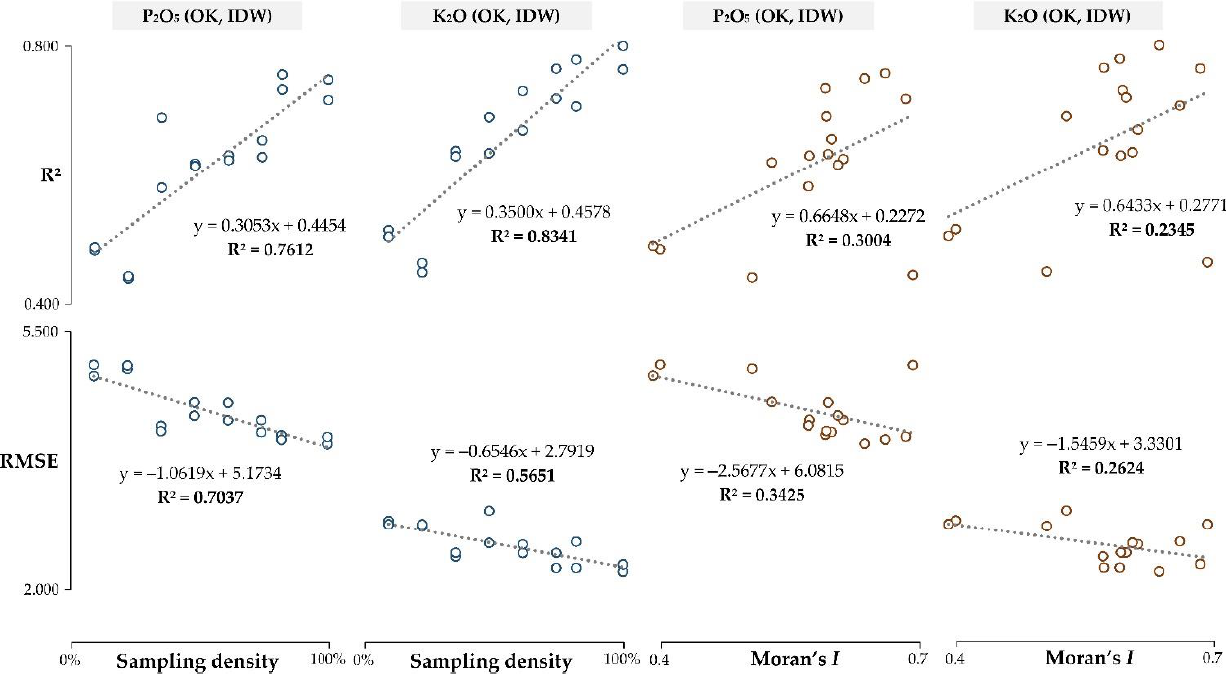
Figure 6. The relationship of the spatial autocorrelation and sampling density with interpolation accuracy.